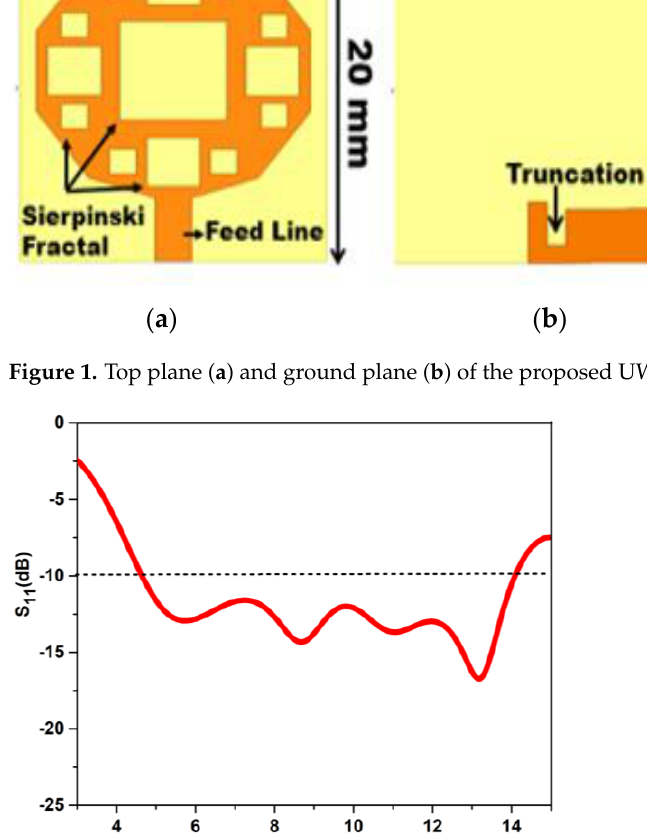
Figure 3. Antenna geometry for ultrawideband.